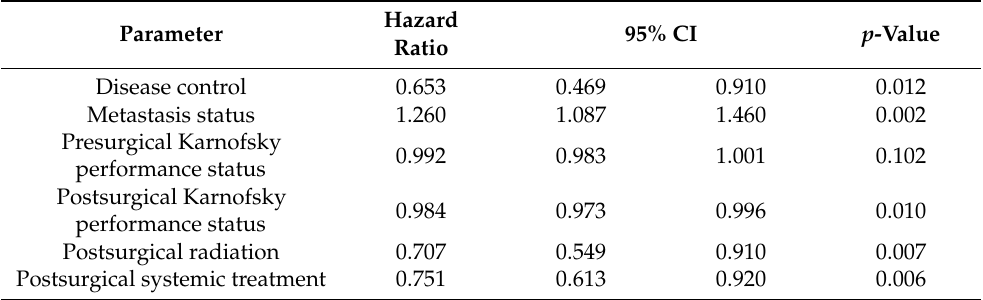
Table 5. Cox proportional hazard regression analysis shows presurgical KPS, metastasis status and control of systemic disease as independent prognostic factors for overall survival in the population younger than 65